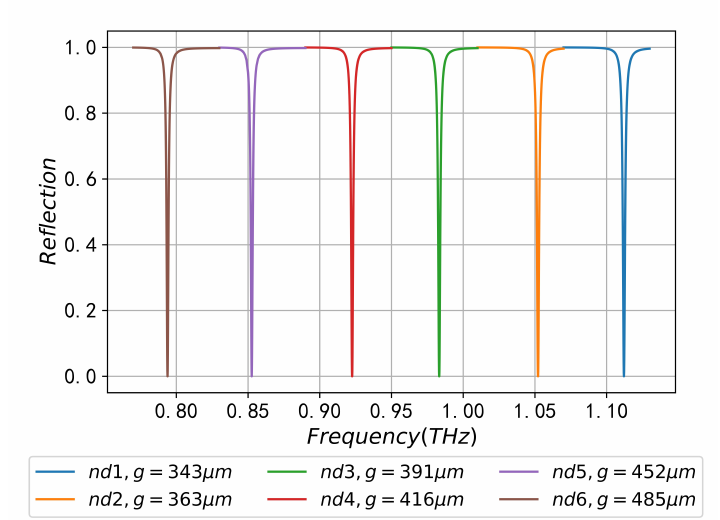
Figure 7. SPR reflection spectra of di ff erent sample refractive indices based on CPGS under optimal coupling